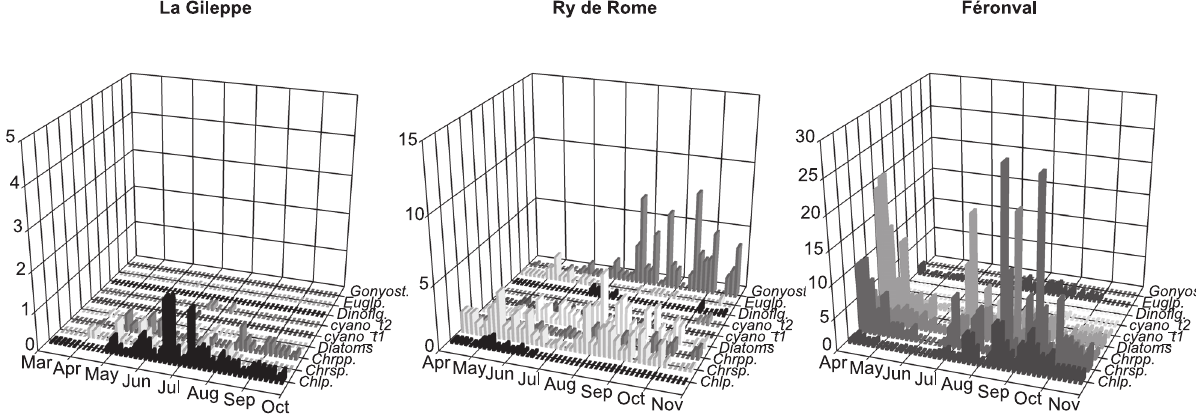
Fig.2. Phytoplantkon community composition. Phytoplantkon community composition over time (from April to October 2010) in the three analysed reservoirs by means of CHEMTAX pigment analyses and expressed as Chlorophyll a equivalents ( m gr L 2 1